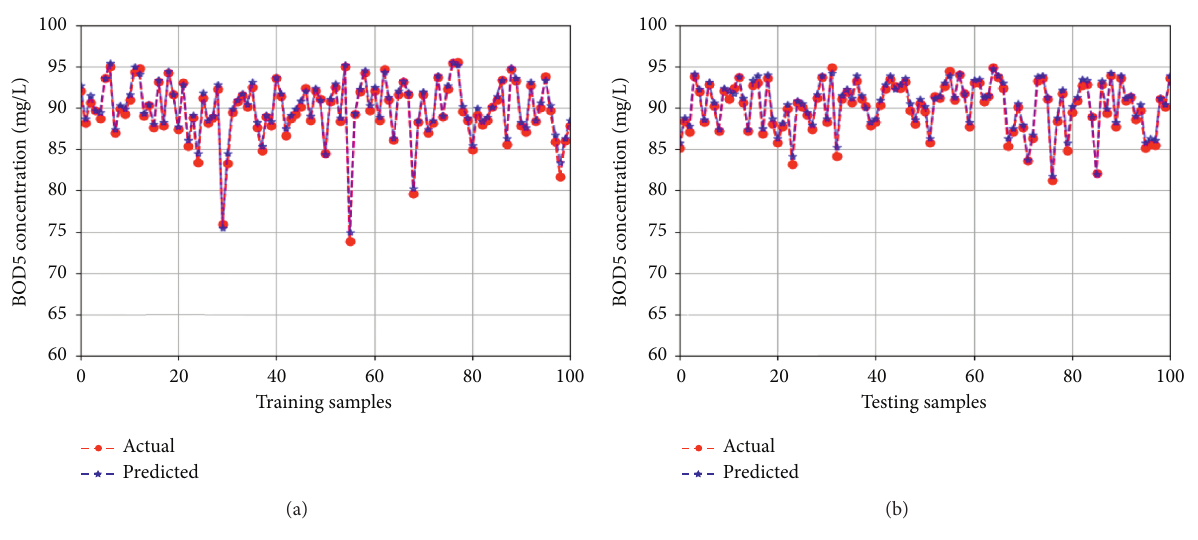
Figure 5: Soft sensor performance prediction based on SAE-NN. Table 2: Results of different models of soft sensors.